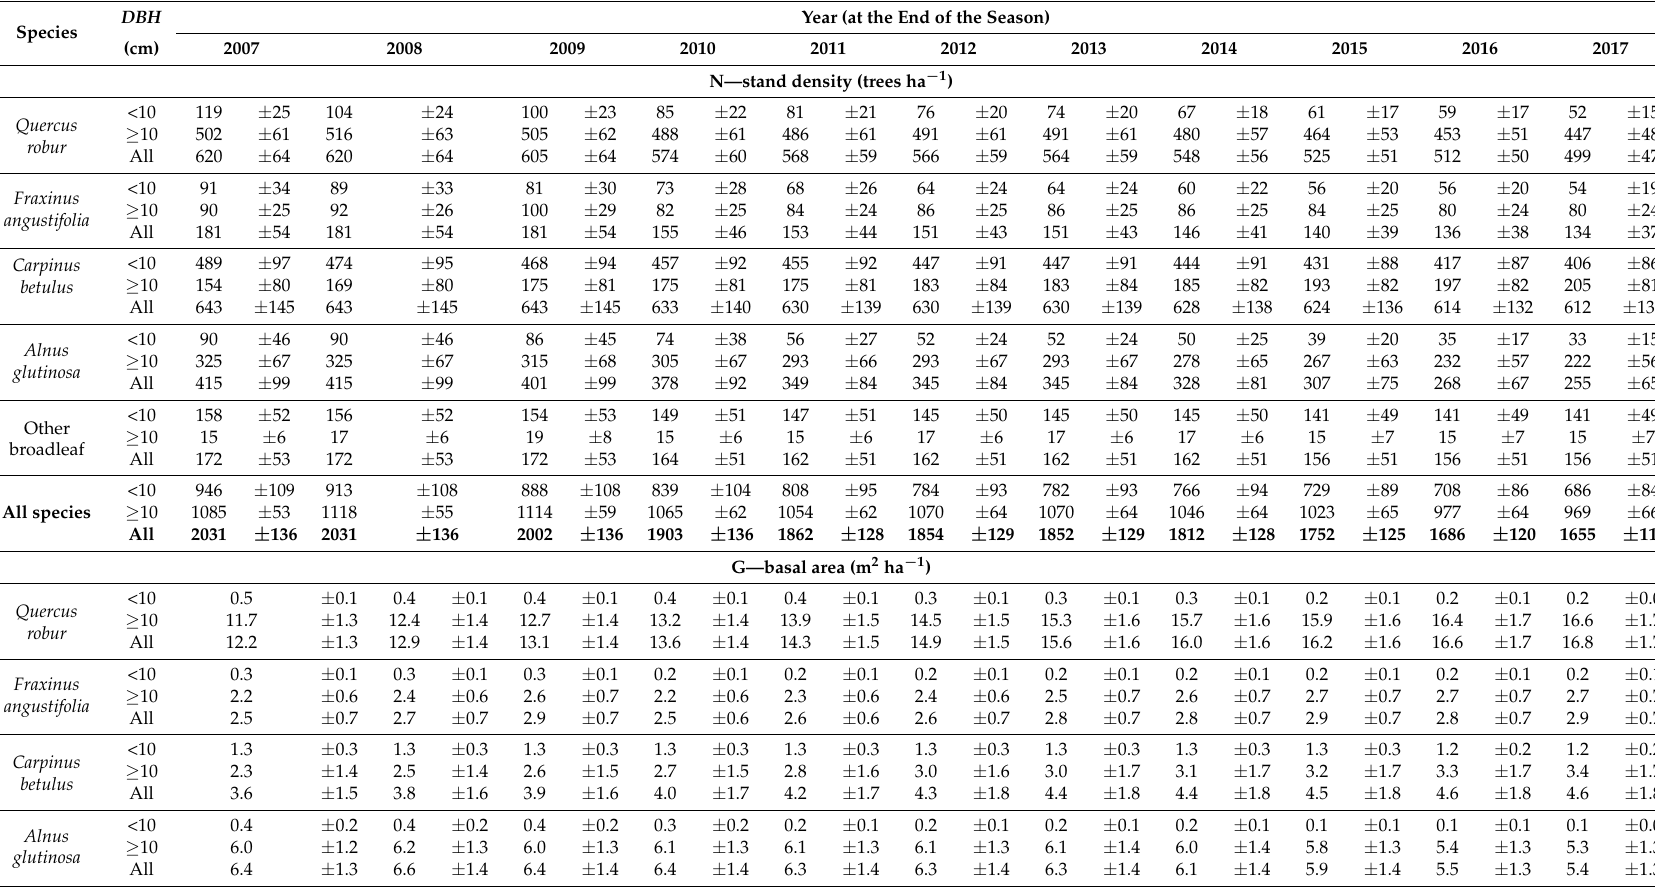
Table A8. Temporal evolution of stand density, basal area and wood volume, according to tree species and size class, of the forest in the area around the eddy covariance tower (mean (std.